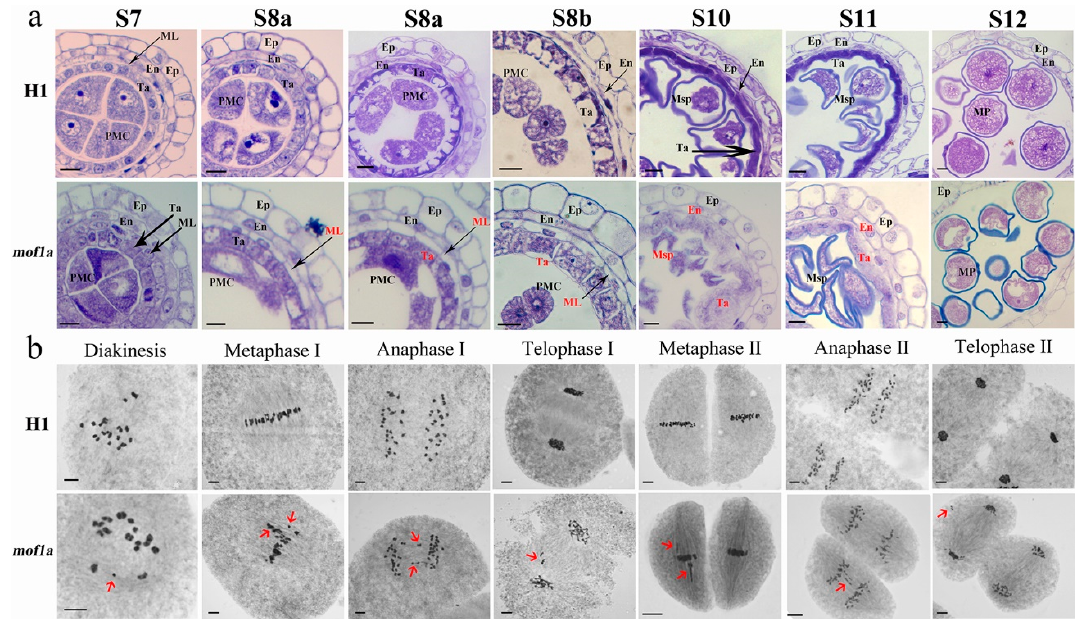
Figure 4. Anther transverse section analysis ( a ) and meiosis process ( b ) of WT and mof1a. Ep, epidermis; En, endothecium; ML, middle layer; Ta, tapetum. Red arrows indicate abnormal chromosome. Bars = 20 µm.